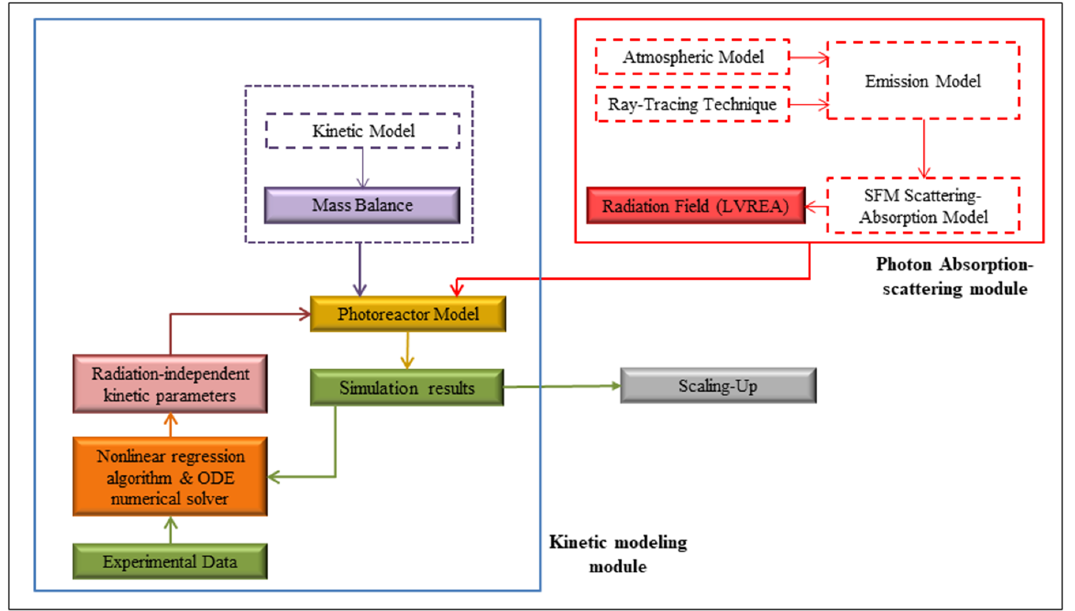
Figure 1. General algorithm for the modeling and simulation of solar slurry photoreactors in PHOTOREAC. ODE: Ordinary Differential Equation; SFM: Six Flux Model.